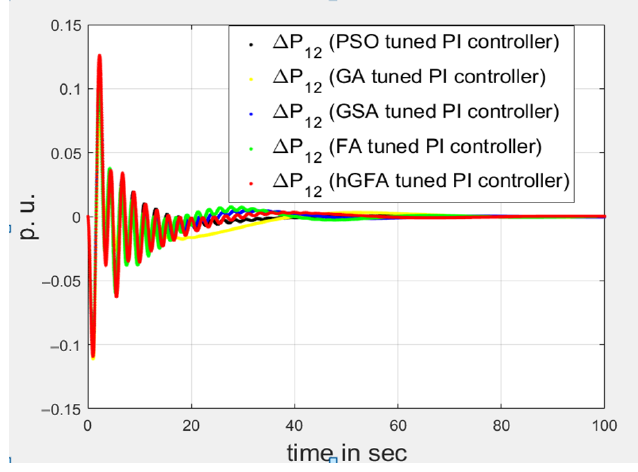
Figure 4. Perturbation in the TLP flow response of HTPS for case study-I.